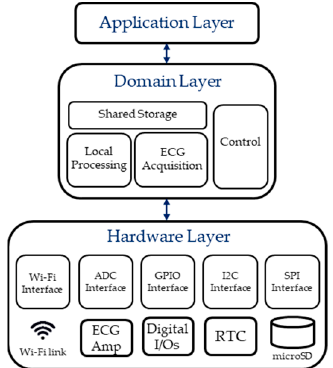
Figure 8. Three-layer firmware architecture for the arm-ECG sensor system (WAMECG1).